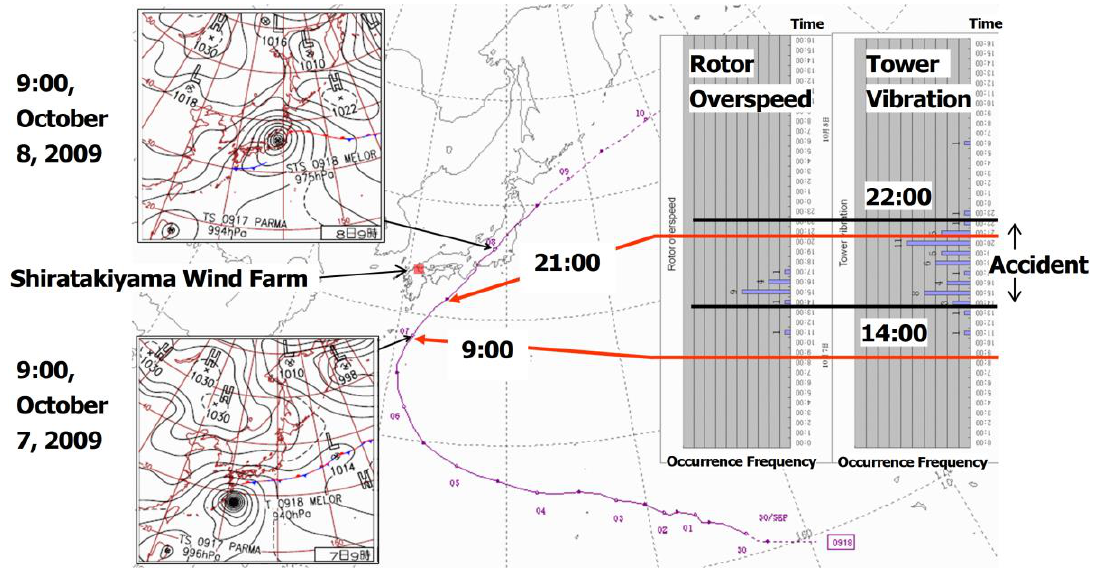
Figure 4. Tracking of Typhoon No. 0918 (Melor) and pressure charts.